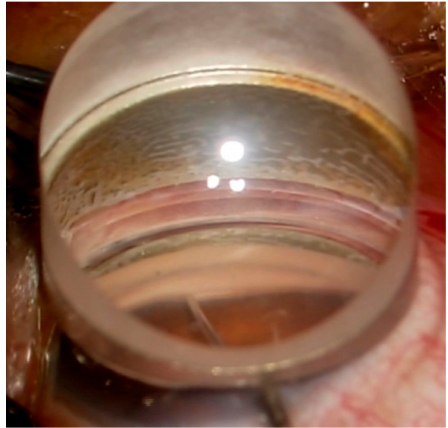
Figure 1. Intraocular picture of microhook trabeculotomy. The inner wall of the Schlemm’s canal and trabecular meshwork is being incised using Tanito